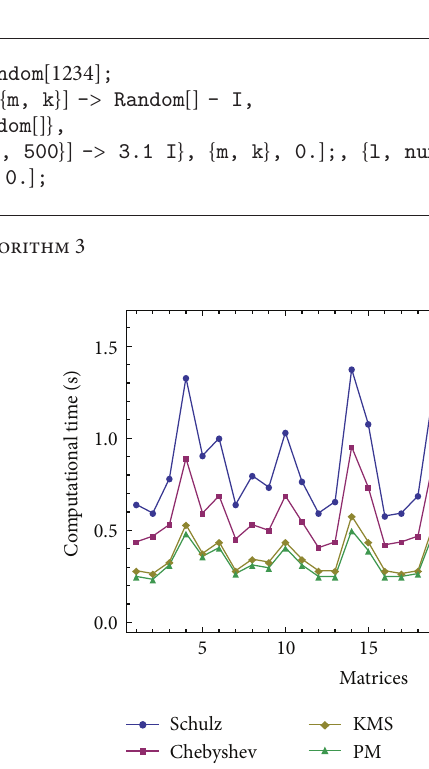
Algorithm 2: Two-argument function written in the Mathematica environment.